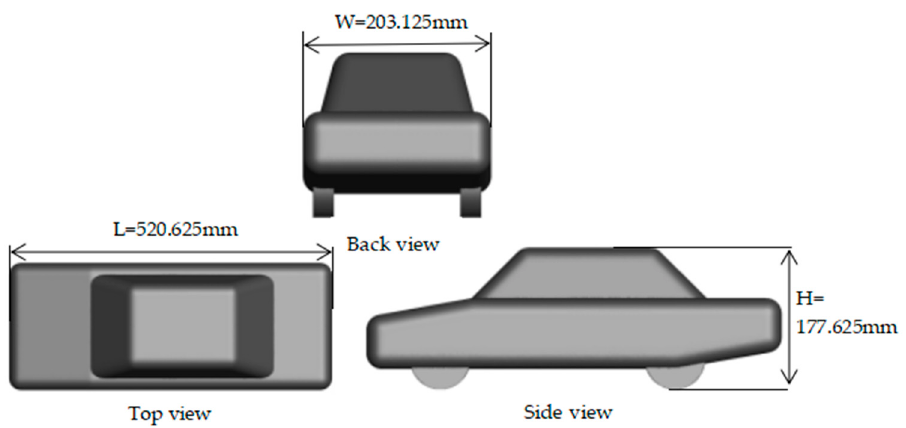
Figure 3. Research vehicle mode.